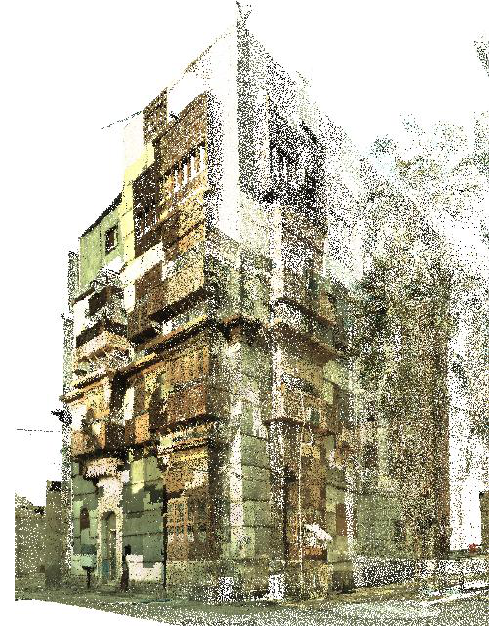
Figure 4. 3D Point cloud